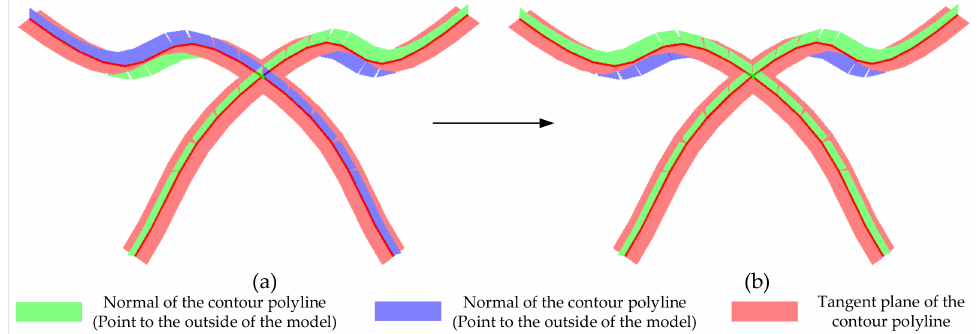
Figure 7. Reoriented normal directions of multiple contour polylines. ( a , b ) show the comparison before and after reorienting normal directions of multiple contour